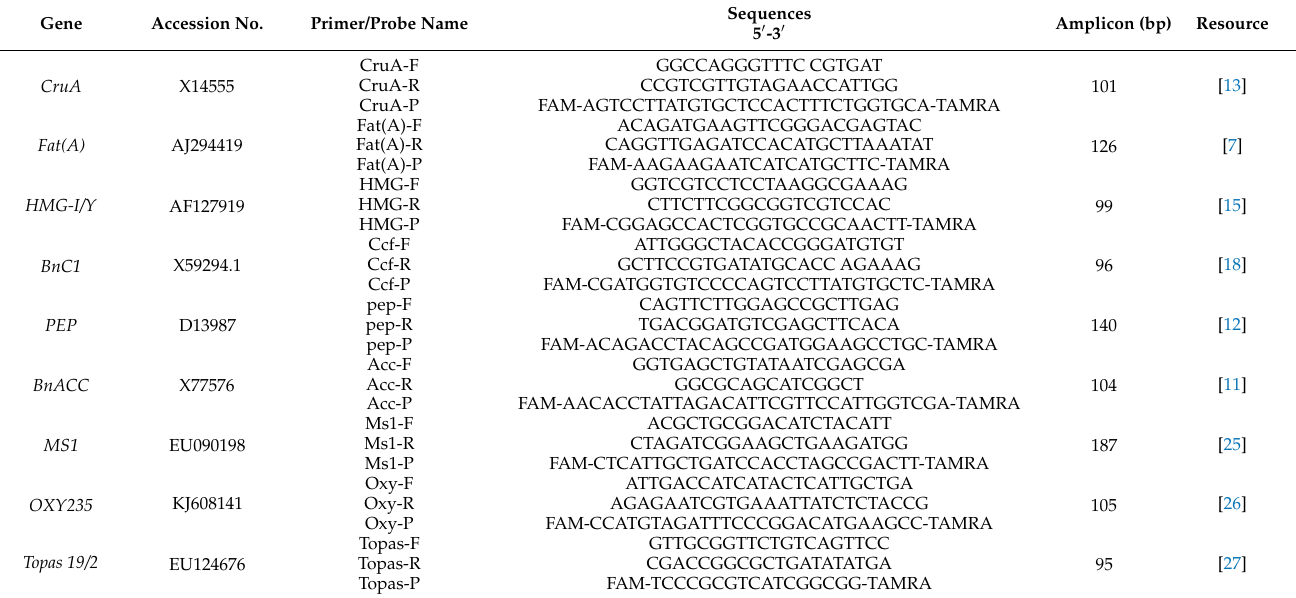
Table 1. Primers and fluorescence probe used in this